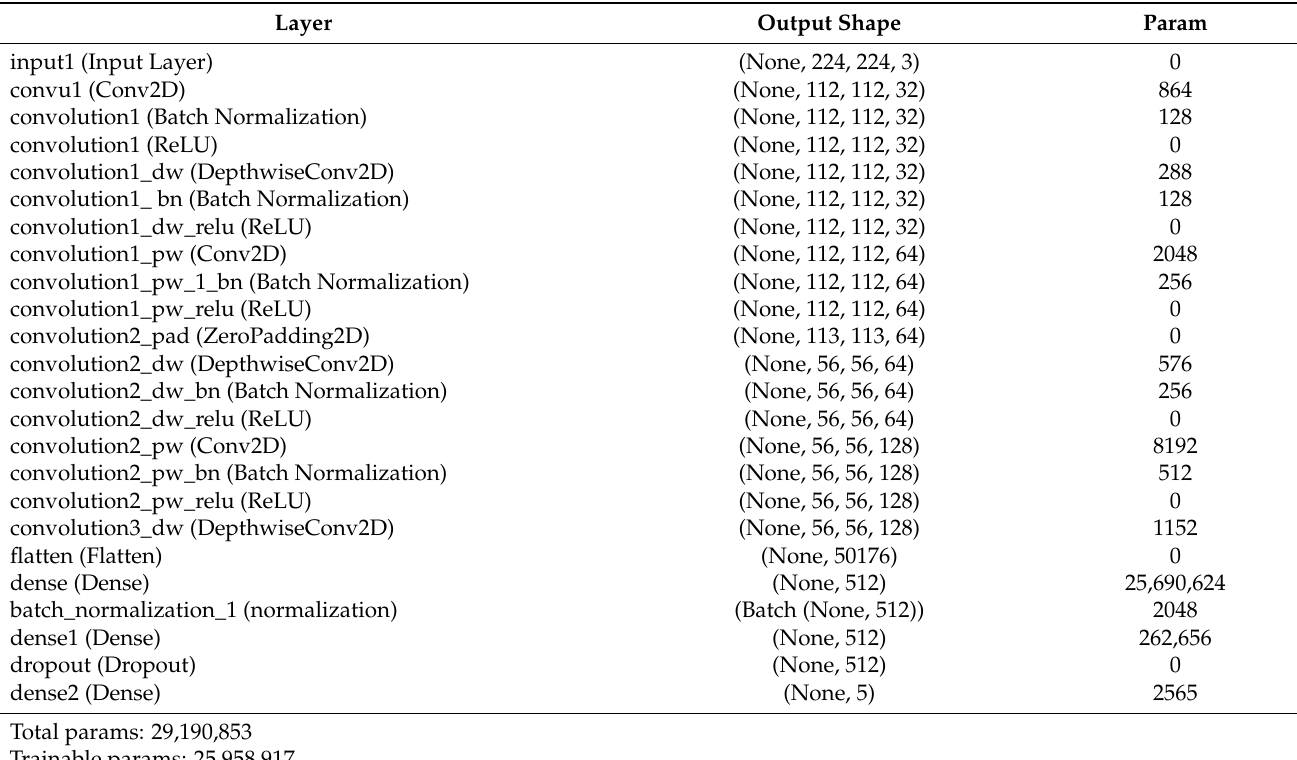
Table 2. Table 2. Shows the general architecture of the MobileNet model with total trainable and non-trainable parameters